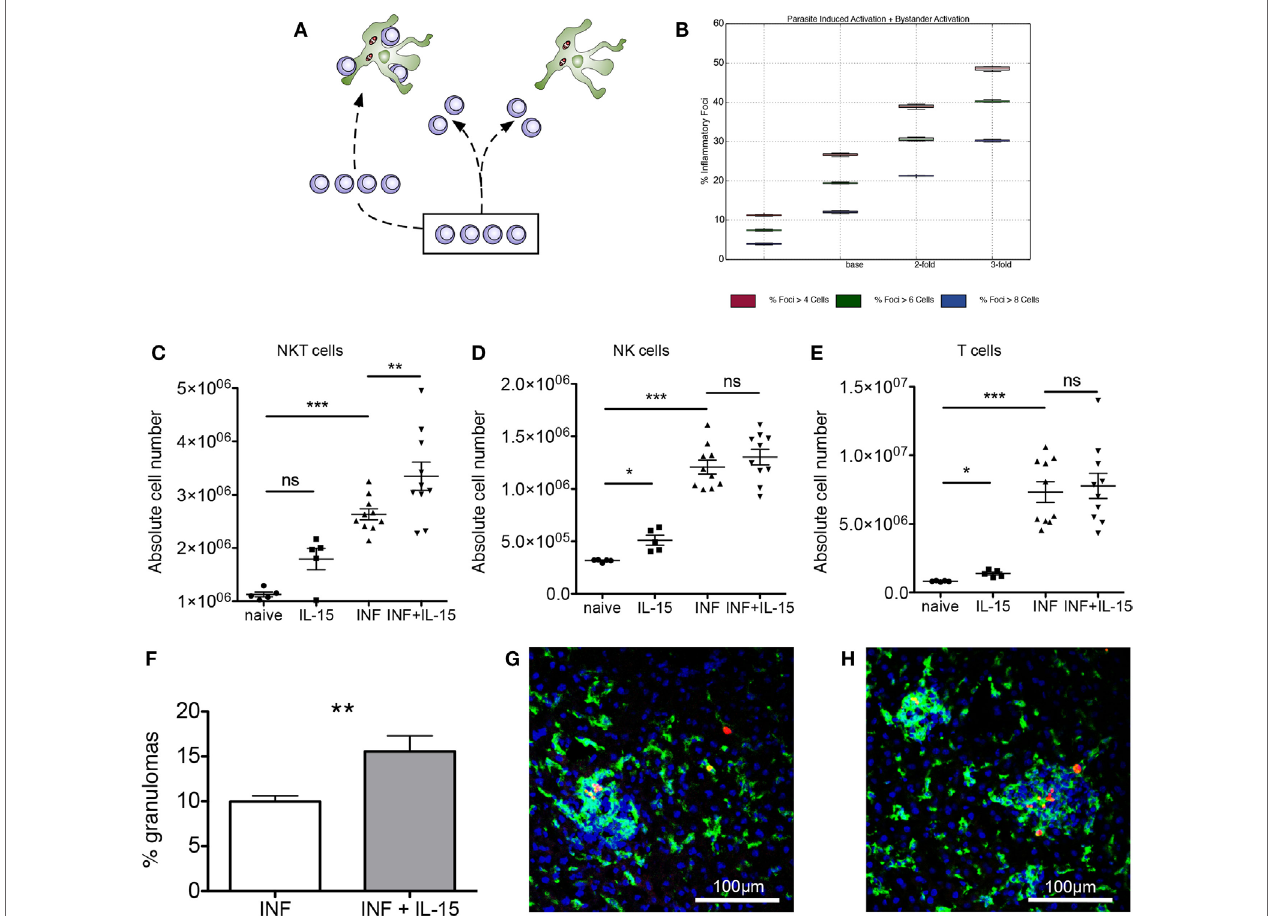
FigUre 4 | Expansion of natural killer T (NKT) cells promotes granuloma formation. (a) Alternate hypotheses for impact of increasing NKT cell number. (B) Increasing NKT cells in silico leads to greater percentages of KCs that form an inflammatory focus, when qualified at 4, 6, and 8 cells. (c–e) Absolute numbers of NKT (c) , NK (D) , and T cells (e) in naïve and infected mice with or without administration of rIL-15. Results are pooled from two independent experiments and represent mean ± SEM ( n = 10 mice per group). * P < 0.05, ** P < 0.01, *** P < 0.001, by paired Student’s t -test. (F) Percentage of infected KCs with surrounding granuloma in control and rIL-15-treated infected mice. ** P < 0.01 ( n = 10 mice). (g,h) Heterogeneity of granulomas comparing infected (g) and rIL-15-treated (h) mice infected with TdTomato- Leishmania donovani (red). Sections were stained using F4/80 (green) and counterstained with DAPI